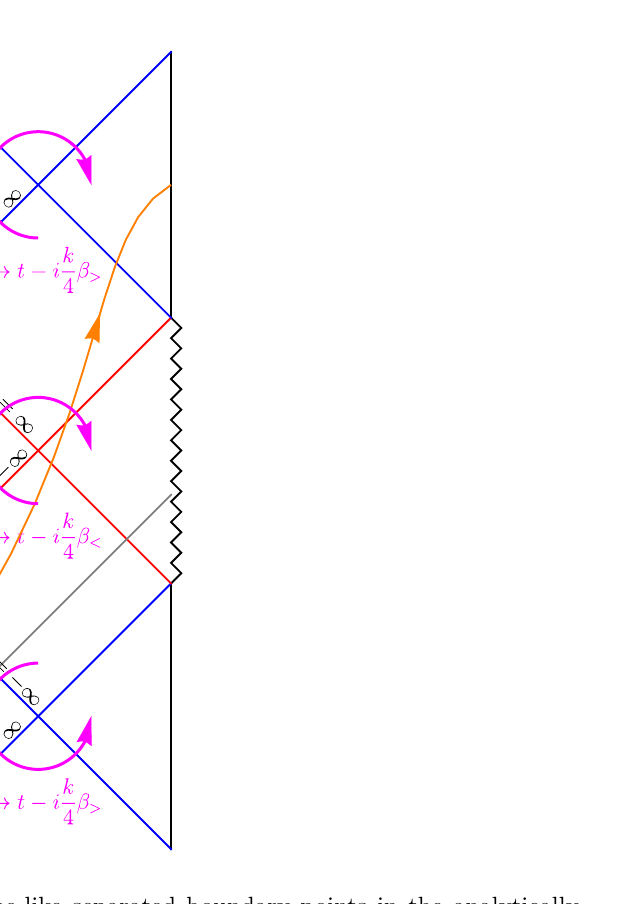
Figure 5 . Moving an operator between time-like separated boundary points in the analytically extended spacetime. First, we send the operator we want to move (orange dot) to the future of all the other insertions (gray dot). Now we can move in the bulk along the orange curve without crossing light cones. In terms of the Killing time, this amounts to sending t 7! + i(cid:12) > = 2 + i(cid:12) < = 2. When we deal with a rotating black hole, we need to be careful that we need to (cid:12)x di(cid:11)erent co- rotating coordinates at the outer and inner horizons, which leads to a continuation that a(cid:11)ects other coordinates besides t